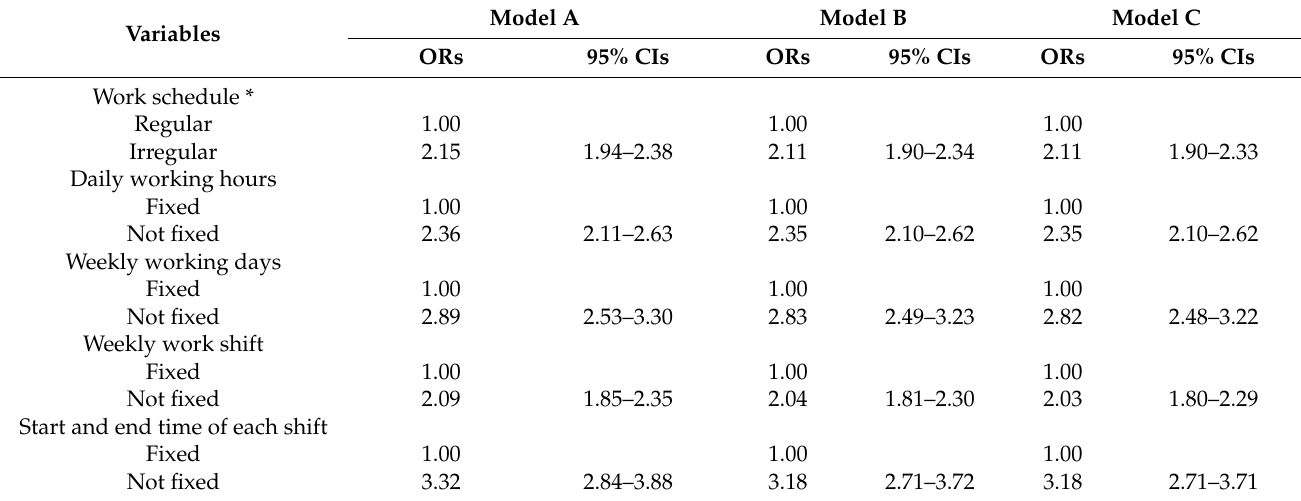
Table 2. Odds ratio and 95% confidence intervals for moderate sleep disturbance.